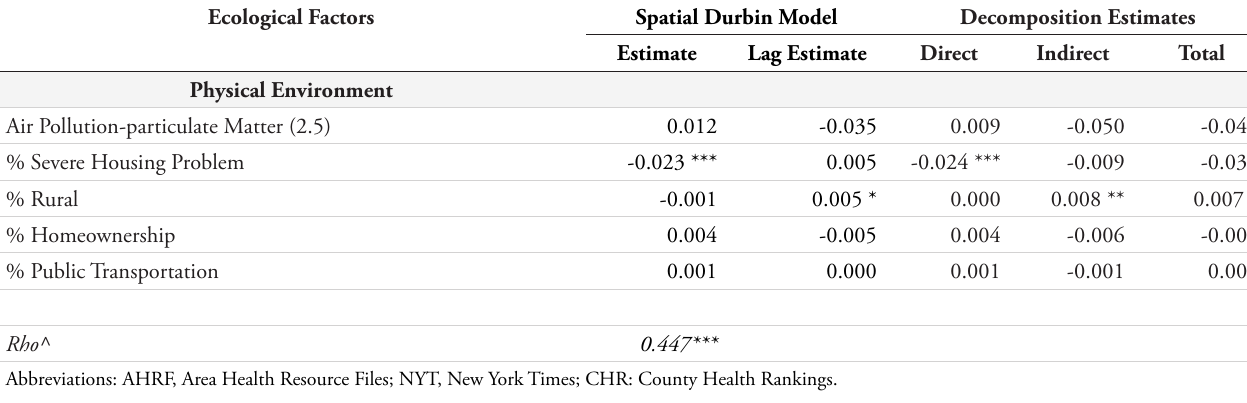
Table 3: Spatial Durbin Model for the Case Fatality Rates as of February 27, 2021 Using NYT 1 , AHRF 24 , and CHRF 26 Datasets Ecological